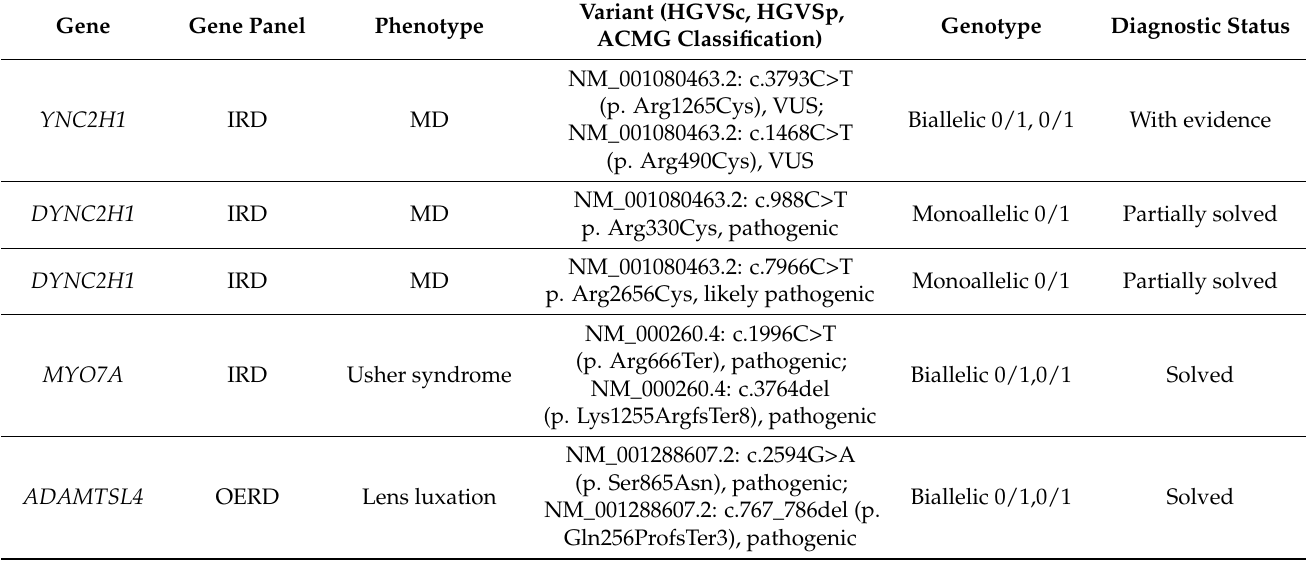
Table 4. New diagnostic status produced by the reassessment of non-solved IRD cases with deleteri- ous variants in the genes prioritized. Details about five IRD non-solved cases with variants adding knowledge to the phenotype. The gene panel column refers to the type of diseases that the gene has been associated with, inherited retinal dystrophies (IRD), and other eye-related diseases (OERD). In the phenotype, abbreviations are MD: macular dystrophy. In variant column, HGVSc, HGVSp, and ACMG classification are included. Genotype column has information about the genotype of the variant(s) in the sample. Diagnostic status column has the new diagnostic status of the case after the reanalysis, as (1) “solved”, when the case has a conclusive diagnosis thanks to the variant(s) identified; or (2) “non-solved”, in any other case. Non-solved cases were annotated according to findings that may help in a future diagnosis as (2.1) “partially solved”, if a heterozygous pathogenic or likely pathogenic variant is found within a recessive gene that fits the observed phenotype; and (2.2) “with evidence”, when the variants identified in the analysis are: (2.2.1) pathogenic/likely pathogenic variants in genes not yet associated with the disease but with some evidence published in the literature or with overlapping phenotypes, or (2.2.2) VUS in a gene associated with the phenotype when one VUS in dominant or 1–2 VUS in recessive genes were